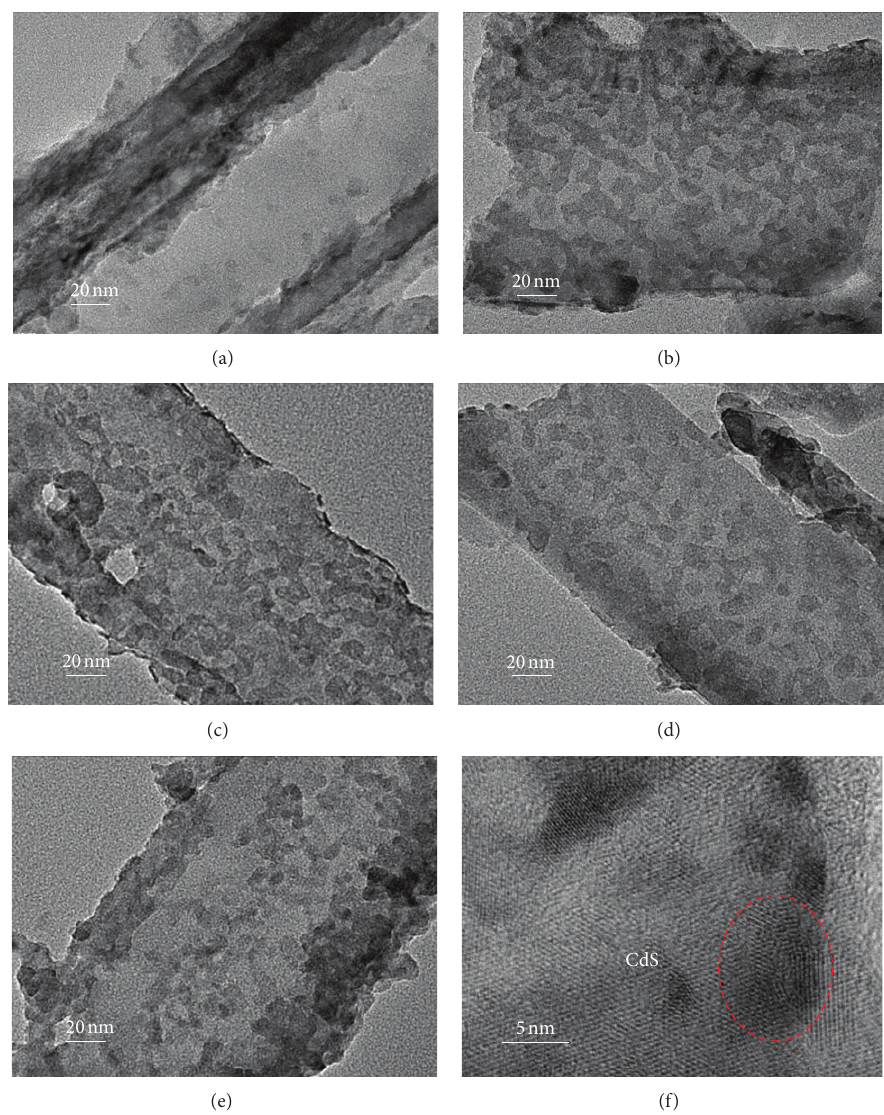
Figure 3: TEM images of (a) CdS/TNAs without surface treatment and CdS/TNAs treated by (b) TiCl 4 , (c) HNO 3 , (d) KOH, (e) MTMS, and (f) correspond to high-resolution TEM image of HNO 3 -modified